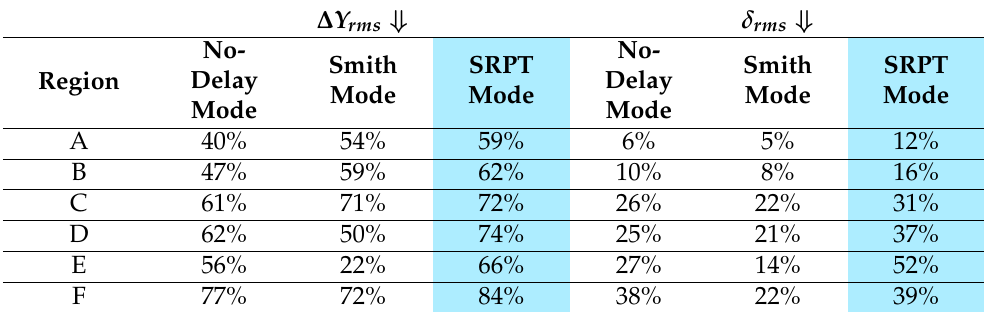
Table 3. Performance improvement in ∆ Y rms and δ rms . SRPT mode performance is highlighted with blue